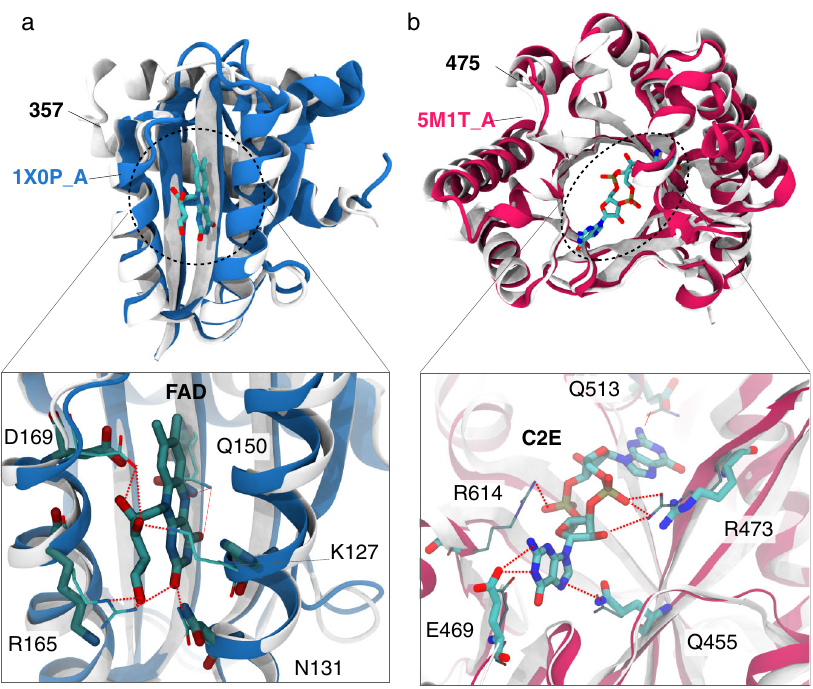
Fig. 5 | Superimposition of the predicted structures for sequences 357 and 475 and the respective top scoring proteins in FoldSeek. a Structural alignment of 357 with pdb 1X0P(chain A, blue).Shownare fi ve residuesin 1X0Pthatinteractvia their sidechains with the ligand FAD. Of these, three are identical in 357 , and another two correspond to substitutions to the same amino acid type (R165